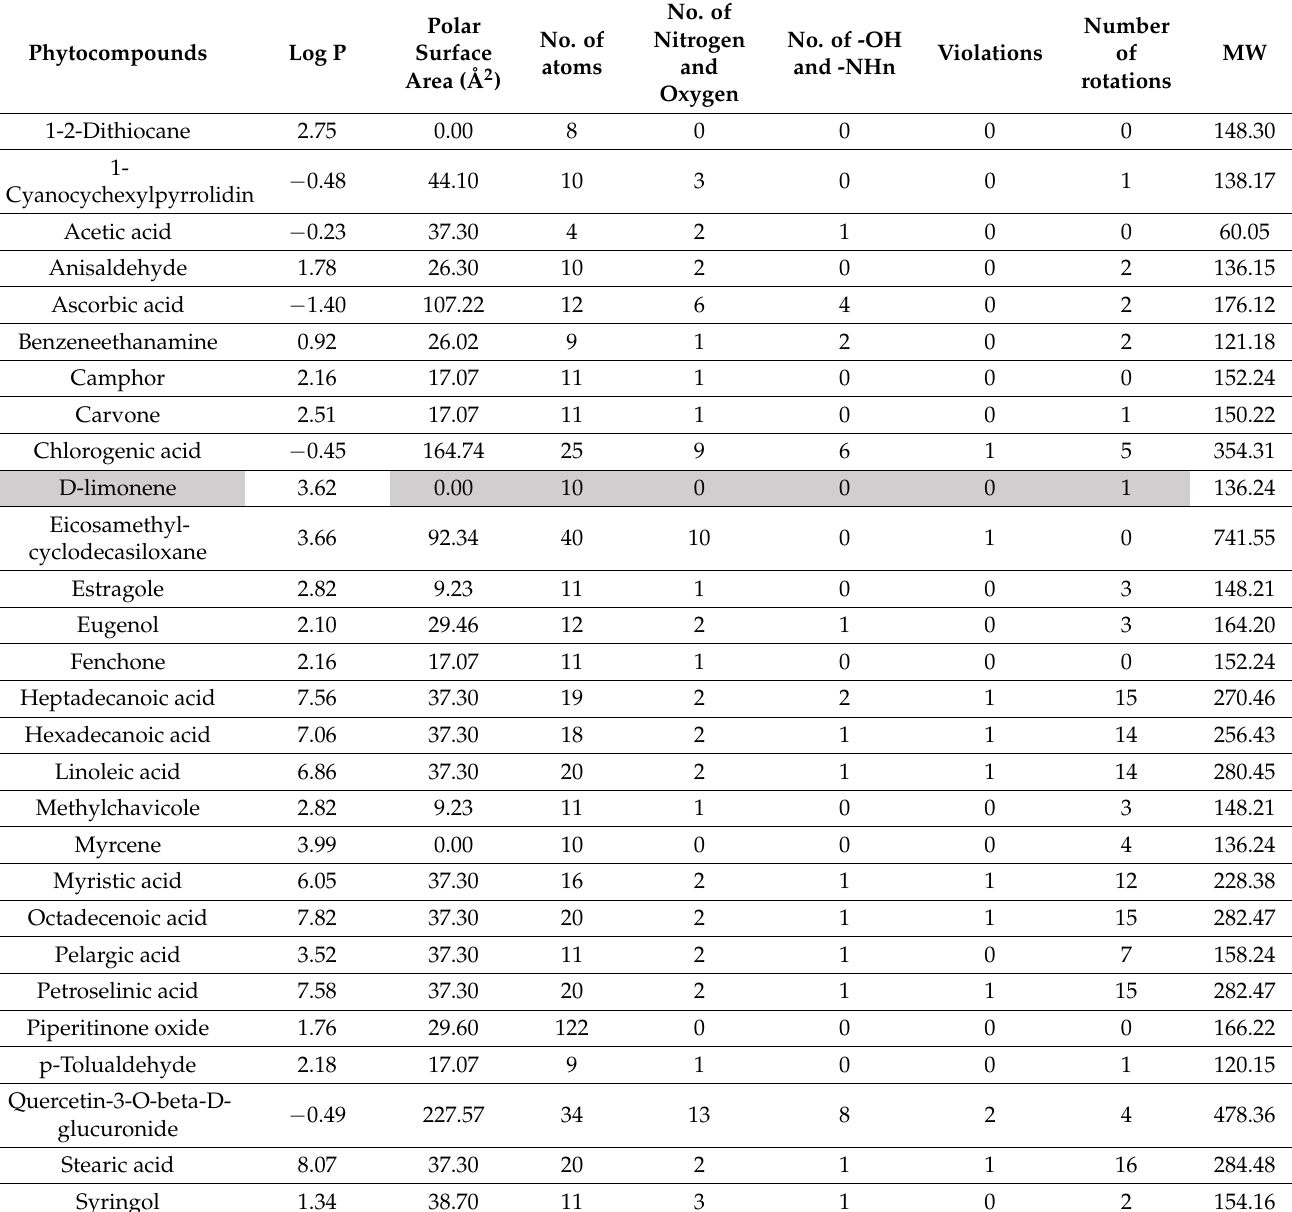
Table 3. Drug-likeness prediction of Foeniculum vulgare phytoconstituents using the Molinspiration web